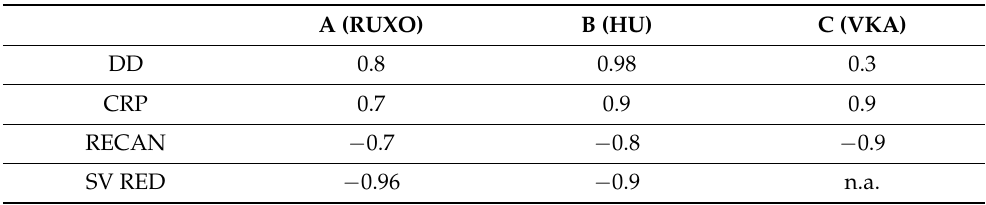
Table 3. Pearson correlation among CEC and DD, CRP, thrombosis recanalization (RECAN) and splenic volume reduction (SV RED). A